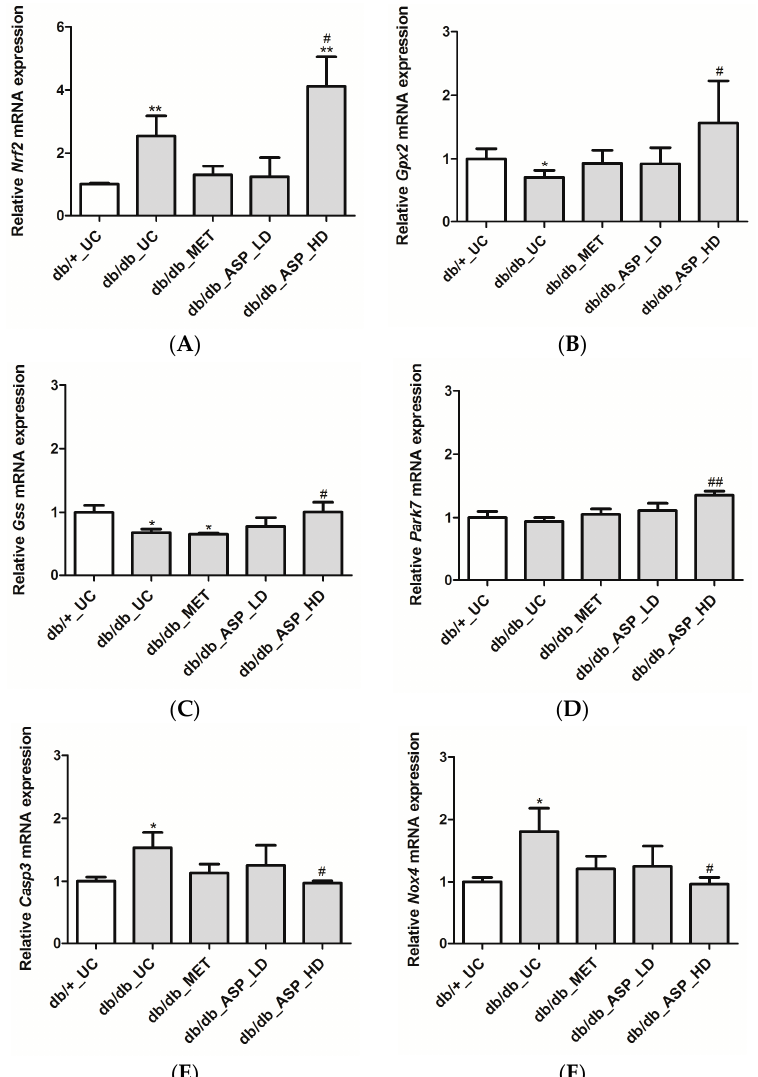
Figure 5. Aspalathin (ASP) prevented oxidative damage by increasing the expression of Nrf2 and its down-stream target genes in diabetic mice. The relative mRNA expression of ( A ) Nrf2 and associated antioxidant genes, including ( B ) Gpx2 , ( C ) Gss , and ( D ) Park7 , and oxidative damage associated genes ( E ) Casp3 and ( F ) Nox4 after the six-week treatment period with metformin, and a low or high dose ASP. Results are expressed as the mean ± SEM and each treatment group contained six mice. * p ≤ 0.05, ** p ≤ 0.001 vs. untreated nondiabetic mice ( db / + _UC), # p ≤ 0.05, ## p ≤ 0.001 vs. untreated diabetic mice ( db / db _UC). db / db _MET: diabetic mice treated with metformin (150 mg/kg); db / db _ASP_LD: diabetic mice treated with aspalathin low dose (13 mg/kg); db / db _ASP_HD: diabetic mice treated with aspalathin high dose (130 mg/kg).